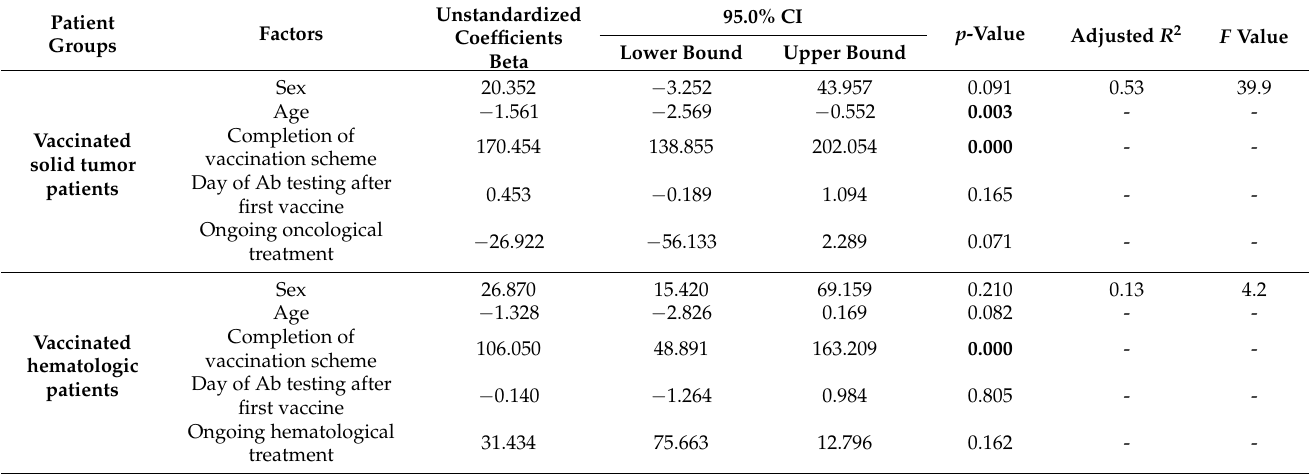
Table 1. Variables associated with antibody response after SARS-COV-2 vaccination in patients with solid tumor ( n = 171) and hematologic diseases ( n = 107). Multivariate linear regression model included completion of vaccination scheme, day of Antibody testing after first vaccine and oncological treatment (ongoing vs. observation-only) and was corrected for sex and